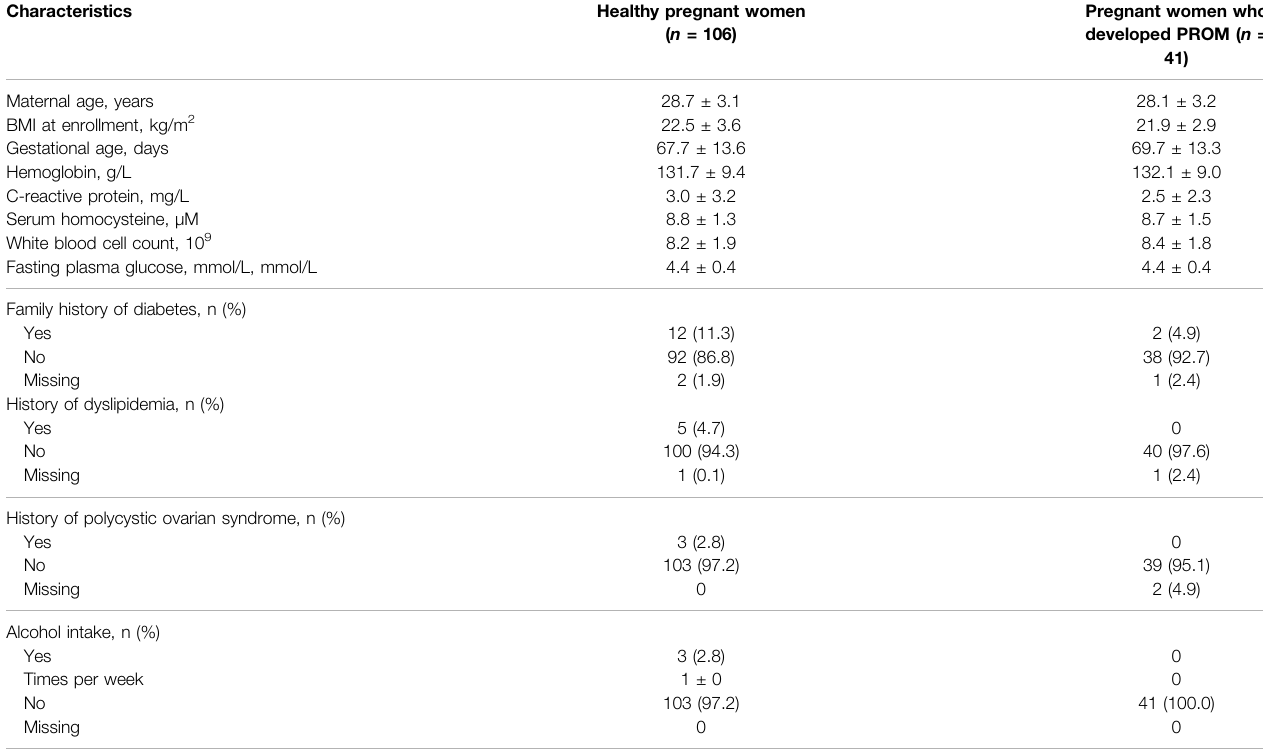
TABLE 1 | Baseline maternal characteristics in healthy control and PROM cohorts in the fi rst trimester.